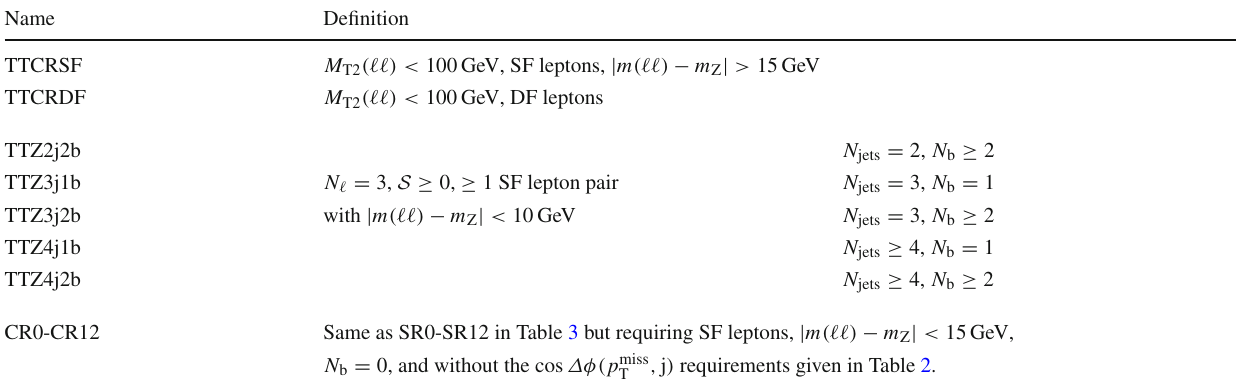
Table 4 Definition of the control regions. The preselection in Table 2 is applied to all